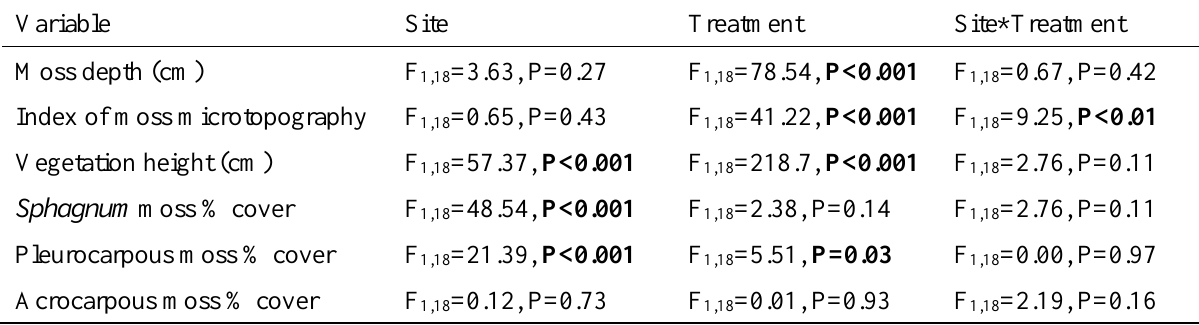
Table 1. Effect of site, treatment (cut or no-cut control) and site*treatment (nested ANOVA) on moss depth, index of moss microtopography, vegetation height and % cover of Sphagnum , pleurocarpous and acrocarpous mosses cover from ten pairs of control and treatment plots on each of two sites. Significant P values are in bold.